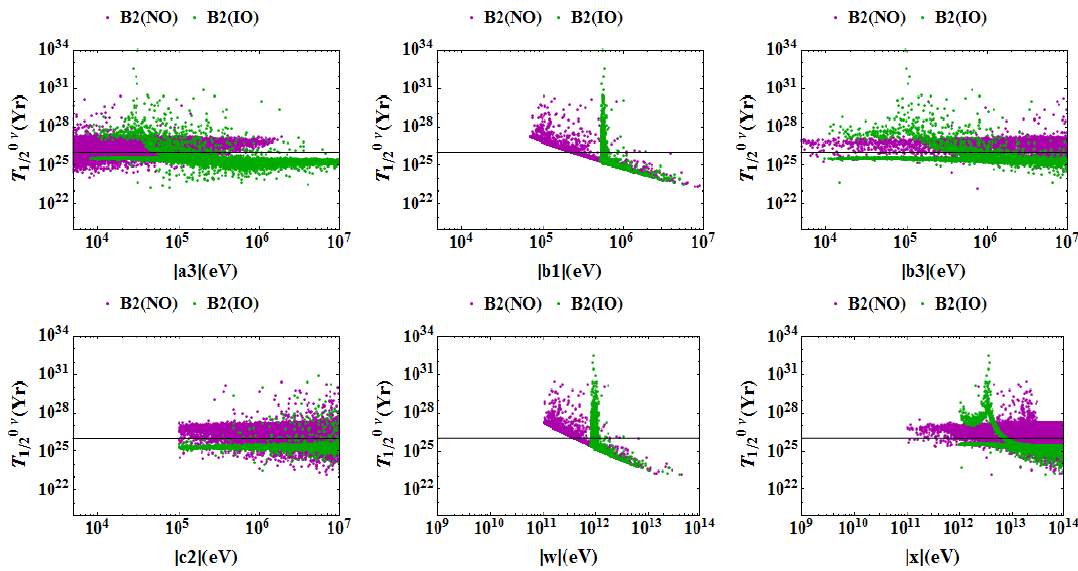
Figure 21 . Total contribution to half-life governing NDBD as a function of the model parameters for the class B2. The horizontal line represents the KamLAND-Zen lower